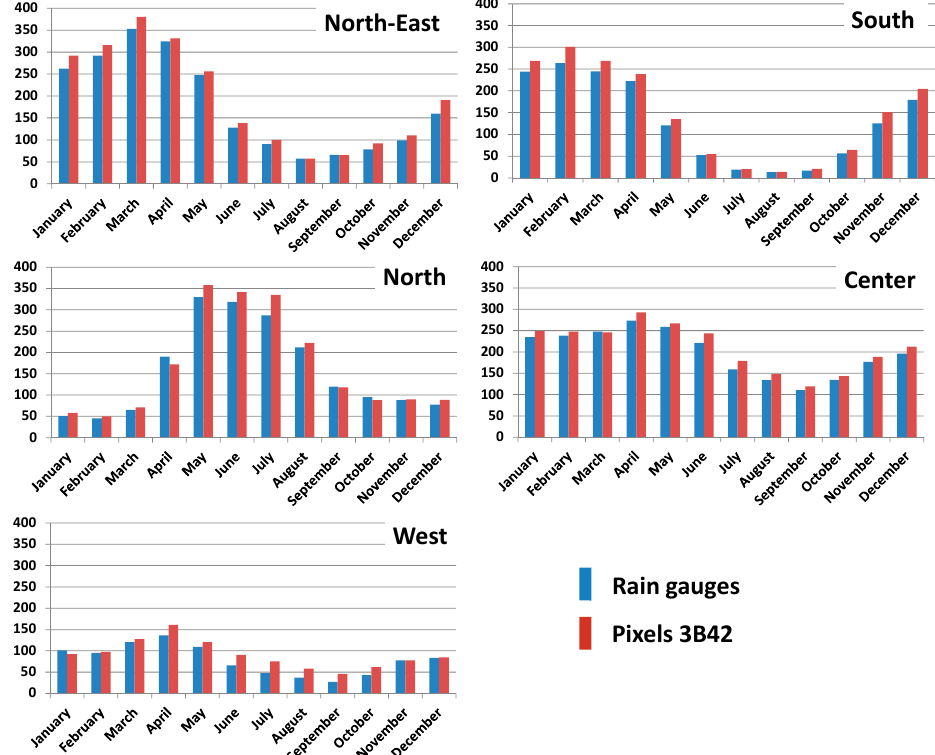
Figure 7. Annual rainfall regimes of the different regions defined in Figure 2 for the AB. The x -axis represents each month of the year, y -axis represents the rainfall in millimeters per month. Blue bars represent the observed rainfall and red ones the estimated rainfall.